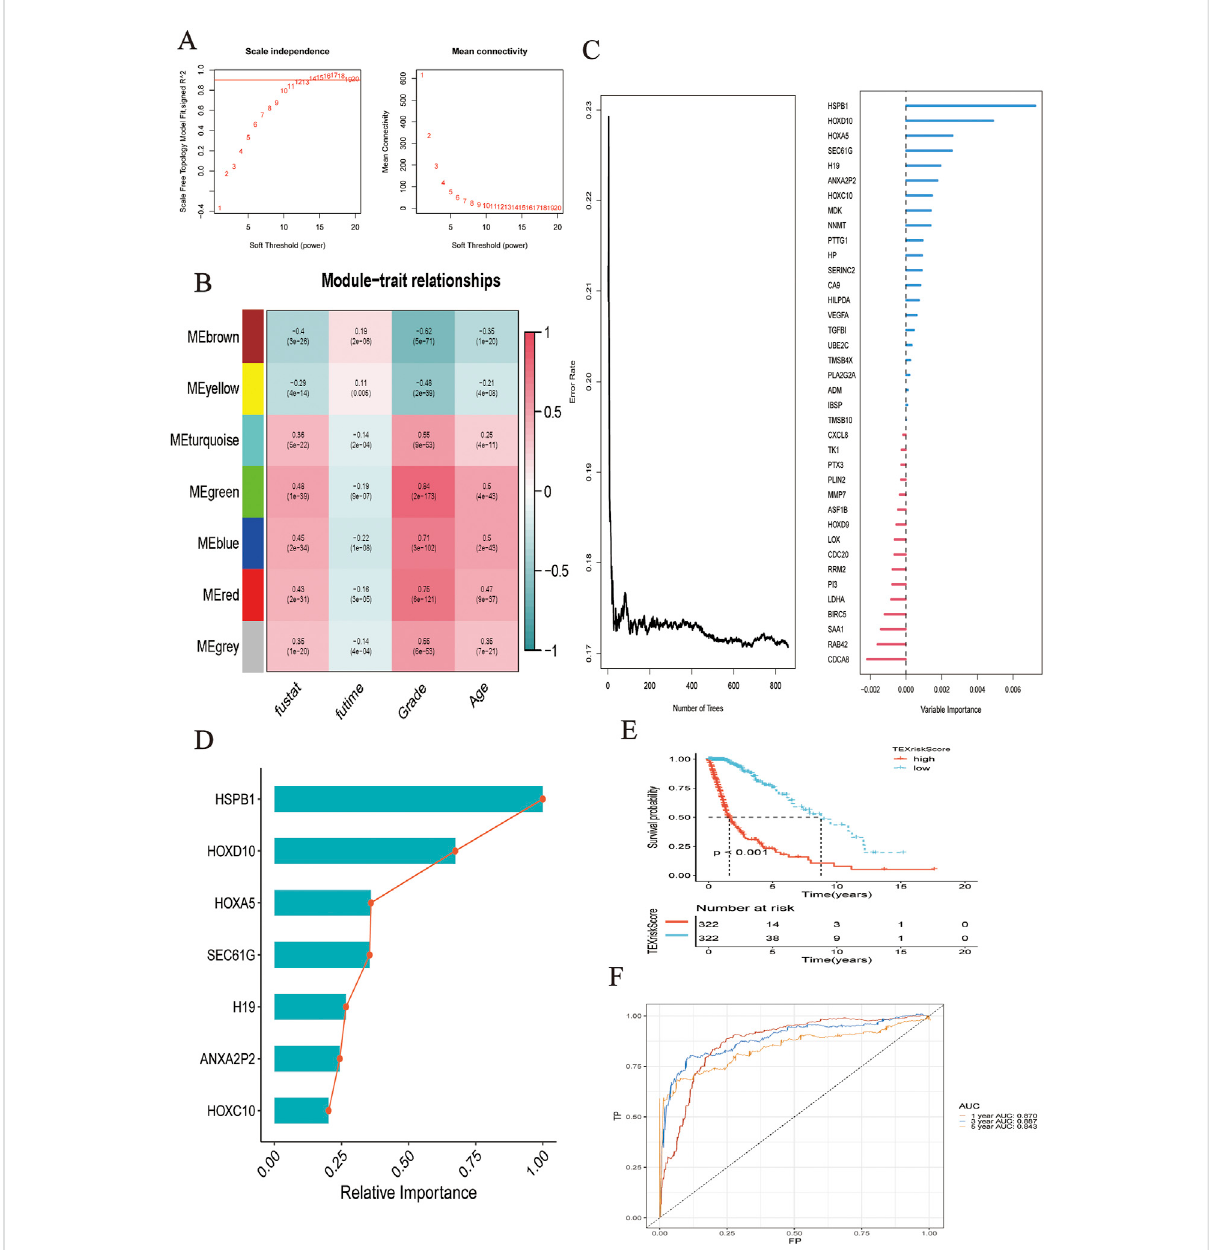
FIGURE 2 (A) Network topology analysis of various soft threshold power. (B) Module-clinical feature association: Each row corresponded to a module feature gene, and each column corresponded to a clinical feature. (C) Survival random forest analysis was conducted to assess the importance of variables. (D) Seven genes were most related to survival. (E) K-M analysis showed the predictive performance of the model. (F) The ROC curve showed the accuracy of the prediction model in predicting 1-, 3-, and 5-year survival